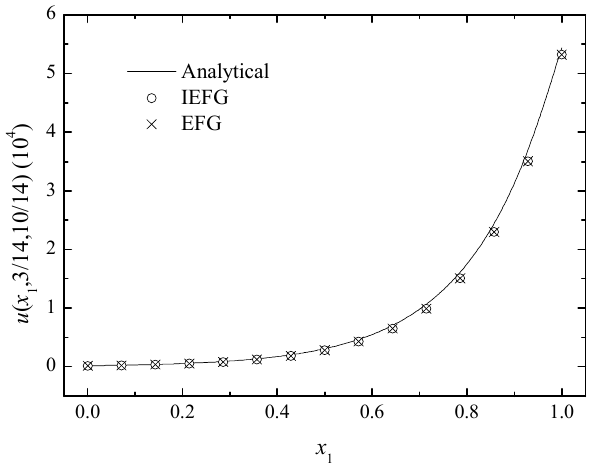
Figure 13. The comparison of the numerical and analytical solutions of the two methods along the x 1 -axis.